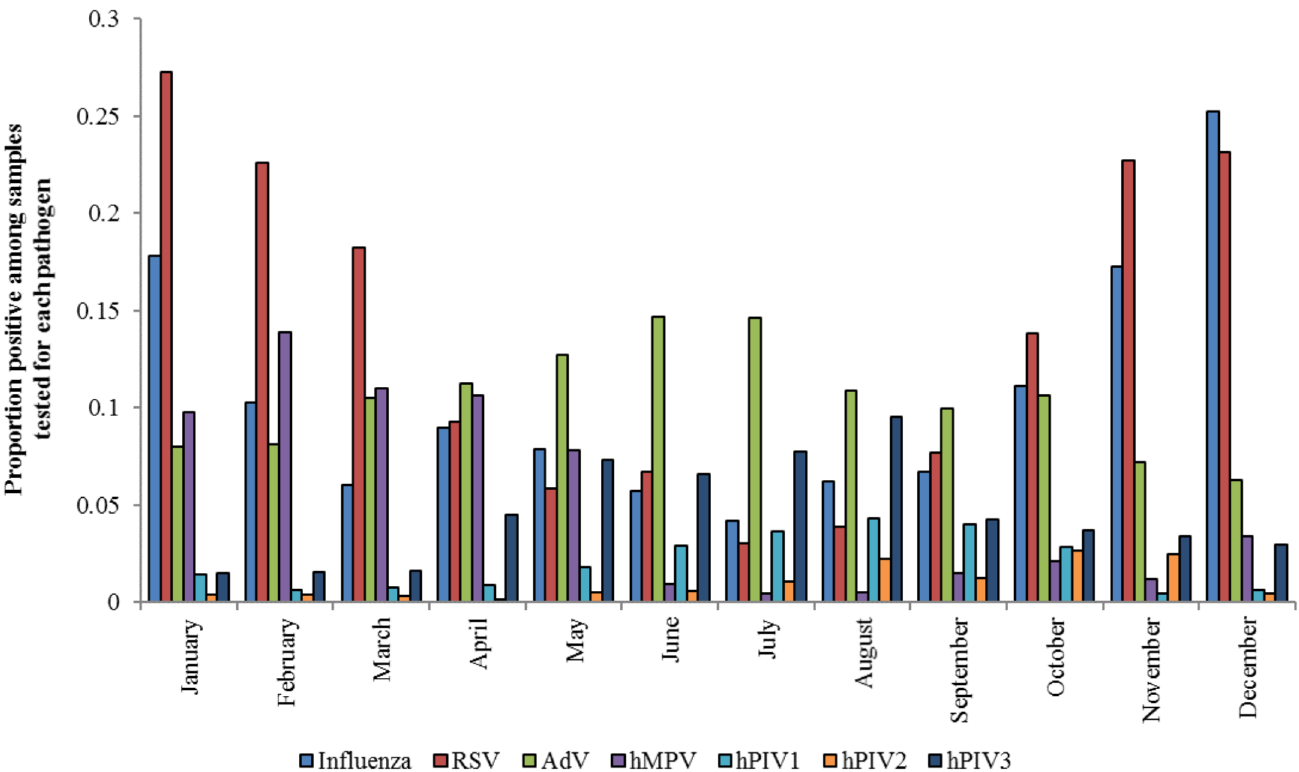
Fig 2. Proportion of positive samples for each viral respiratorypathogen by month. Proportionof positive samples out of total samples tested for each pathogen are shown.